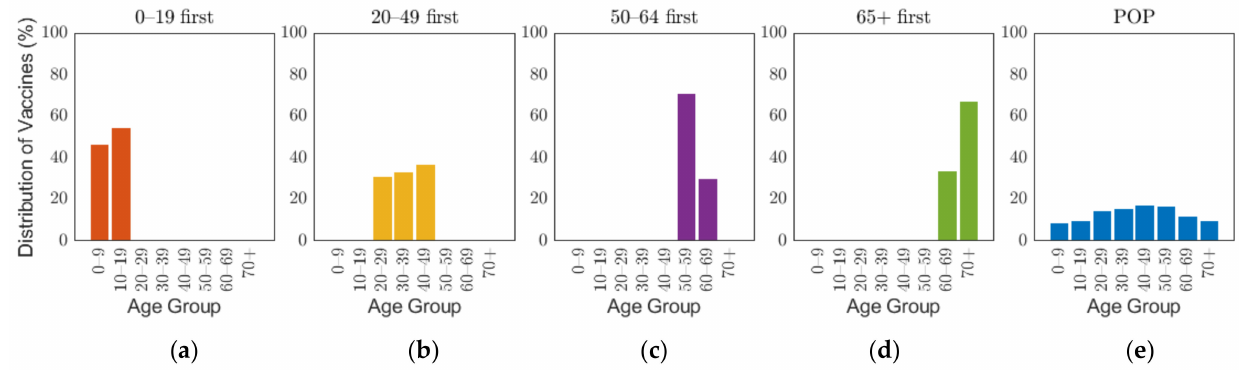
Figure 3. Distribution of vaccine scenarios for five prioritization strategies: ( a ) 0–19 first, ( b ) 20–49 first, ( c ) 50–64 first, ( d ) over 65 first, and ( e ) proportion of population (POP).